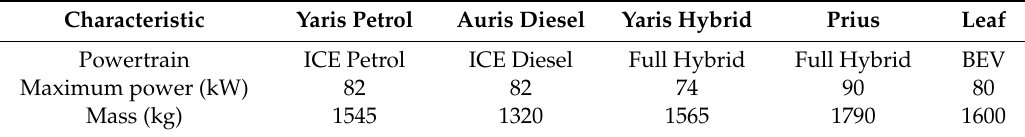
Table 1. Main specifications of vehicle tested.